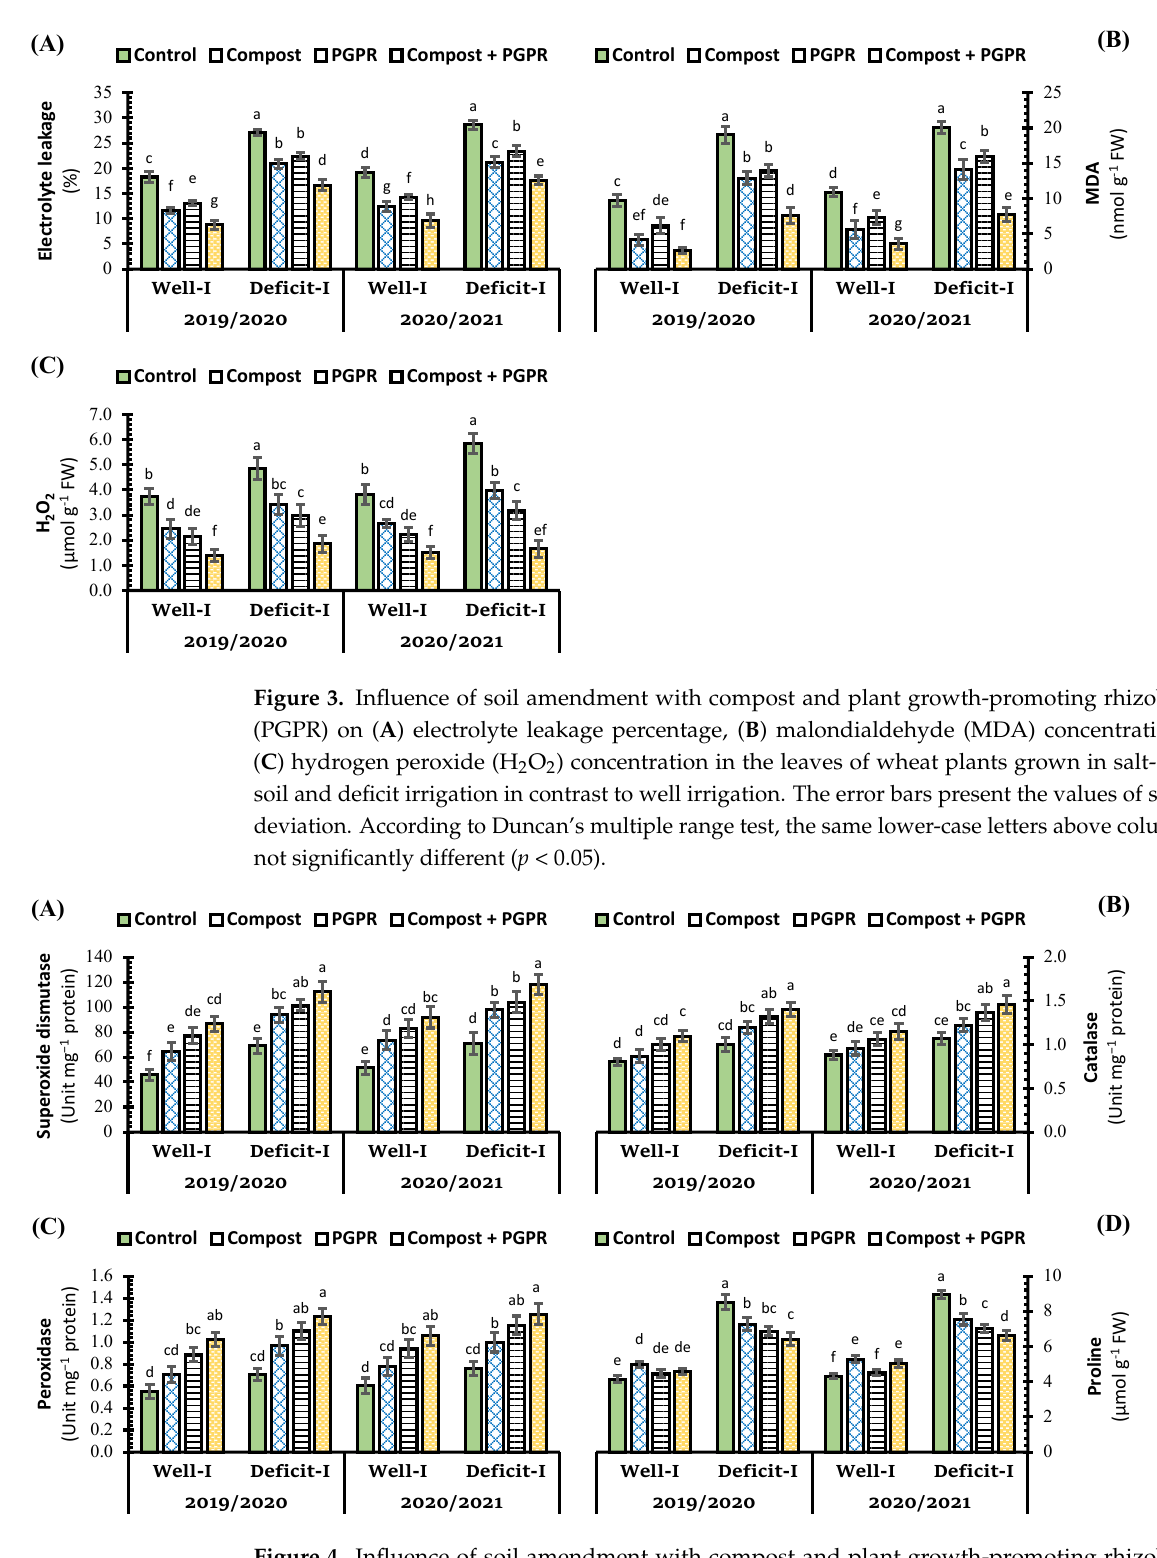
Figure 4. Influence of soil amendment with compost and plant growth-promoting rhizobacteria (PGPR) on the status of antioxidant system ( A ) superoxide dismutase, ( B ) catalase, ( C ) peroxidase, and ( D ) proline concentration in the leaves of wheat plants grown in salt-affected soil and deficit irrigation in contrast to well irrigation. The error bars present the values of standard deviation. According to Duncan’s multiple range test, the same lower-case letters above columns are not significantly different ( p < 0.05).